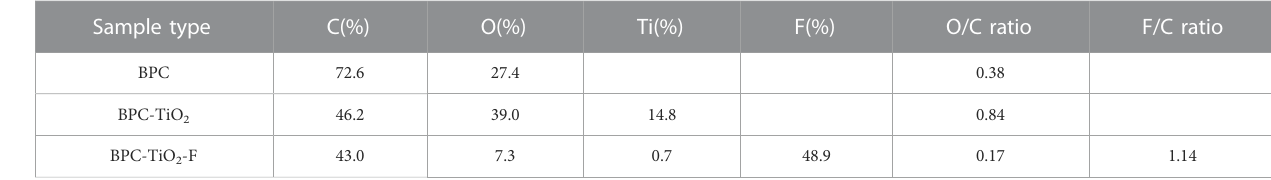
TABLE 1 Atomic composition changes of BPC, BPC-TiO 2 , and BPC-TiO 2 -F.